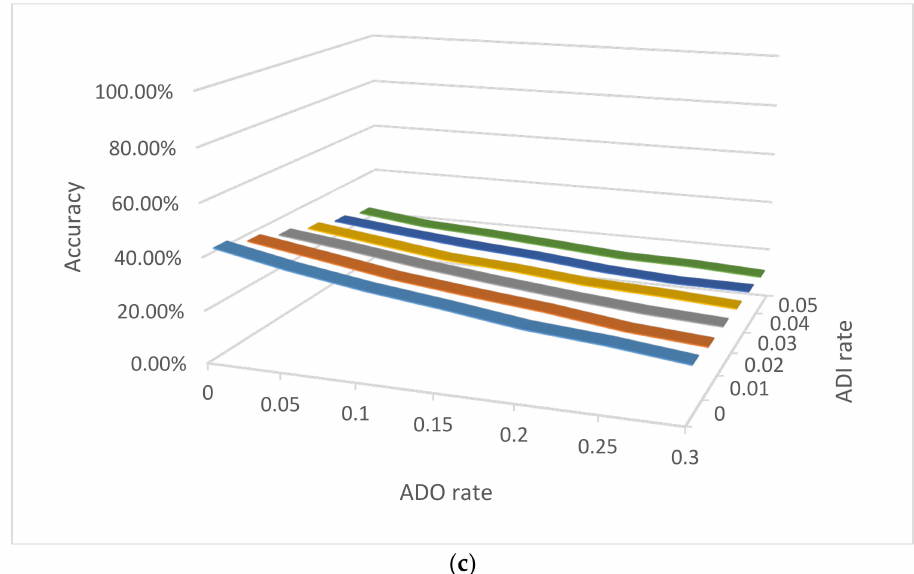
Figure 1. The accuracies of NOC estimation for 3-person mixtures with 2, 6, and 12 single cells with various ADO and ADI rates in three scenarios: ( a ) Diploid cells with three unrelated contributors, ( b ) Diploid cells with three family trio contributors (father, mother, and child), and ( c ) Haploid cells with three unrelated contributors. D = 0.2; e = 0.01; 10,000 simulations for each mixture